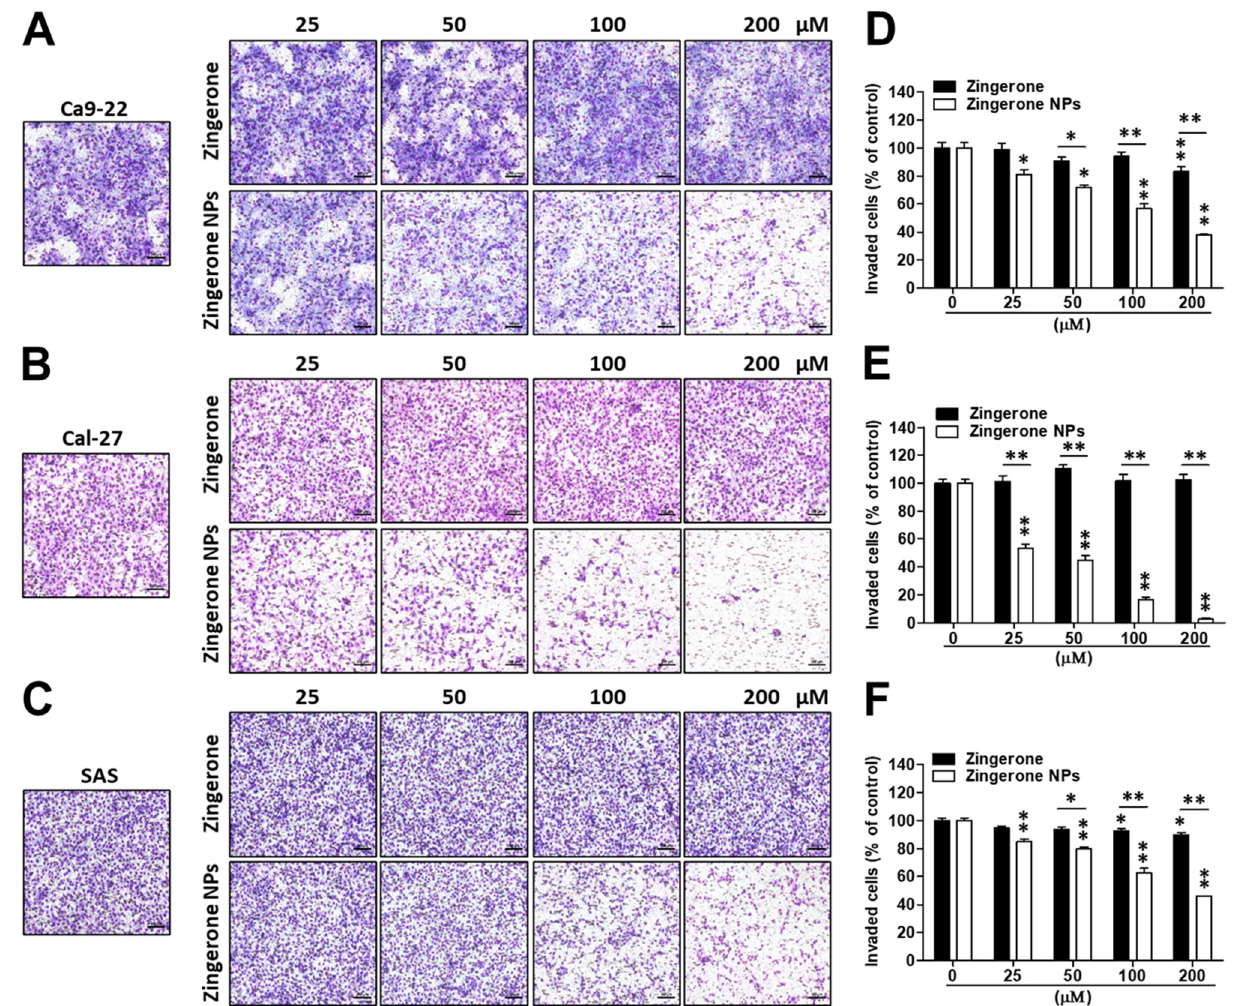
Figure 4. Effect of nanosized zingerone on cell invasion of three human OSCC cell lines. Cells were treated with various doses of zingerone and/or zingerone NPs and then subjected to Boyden chamber assays. Following incubation for an adequate time, the cell invasion of three human OSCC cell lines, ( A ) Ca9-22 cells, ( B ) Ca1-27 cells, and ( C ) SAS cells, was imaged and recorded using inverted microscopy. Bar: 100 µm. The invasive cells of ( D ) Ca9-22 cells, ( E ) Ca1-27 cells, and ( F ) SAS cells were further counted and quantified. Bars represented as mean ± SEM for n = 5 membranes in three separate experiments (* p < 0.05; ** p < 0.01).